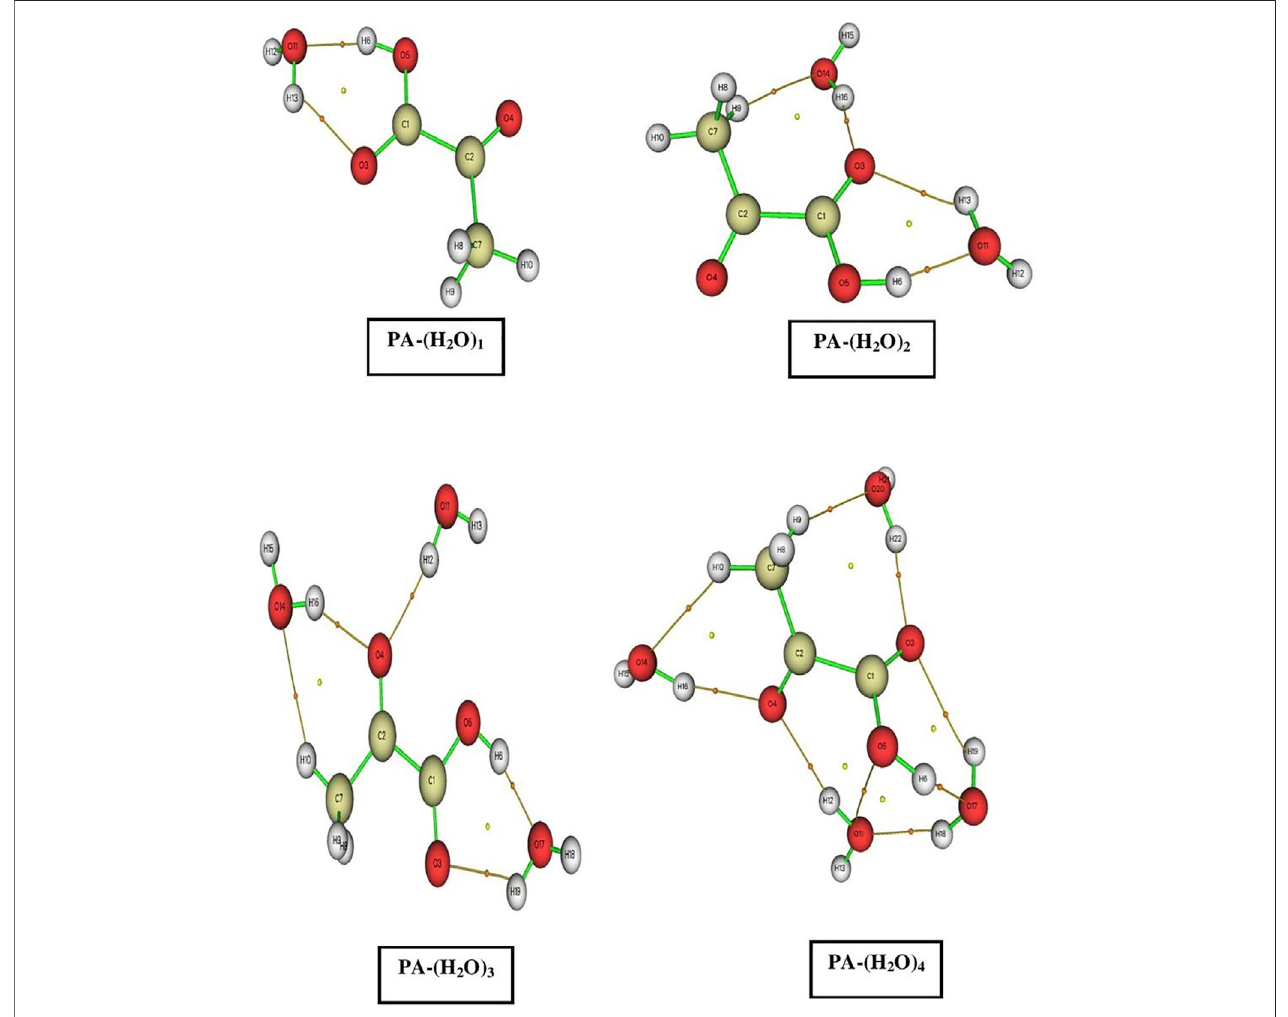
FIGURE 2 | AIM molecular graphs of pyruvic acid – (H 2 O) n = 1 – 4 complexes. The BCP and RCP are marked by the small orange and yellow circles, respectively.